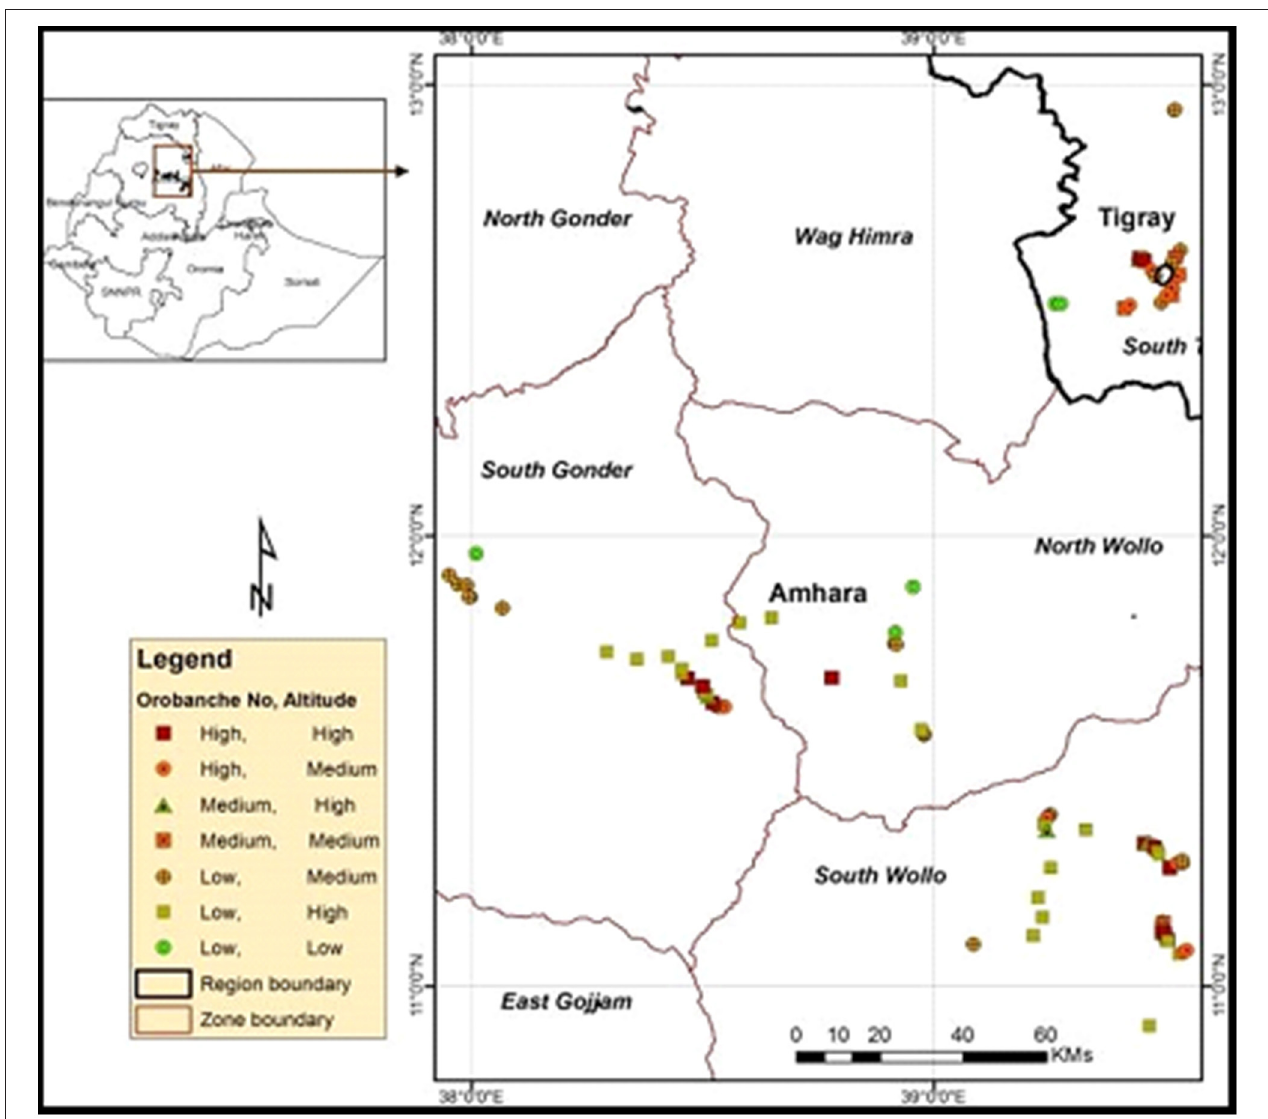
FIGURE 3 | Crenate broomrape distribution in the Amhara and Tigray regions, northern Ethiopia after Belay